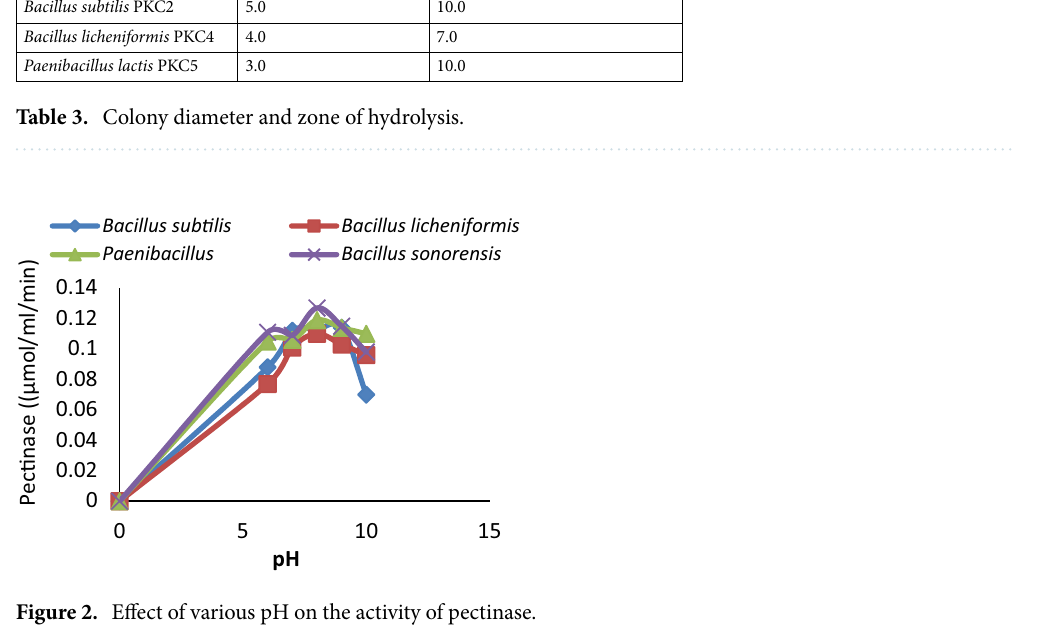
Bacterial strain